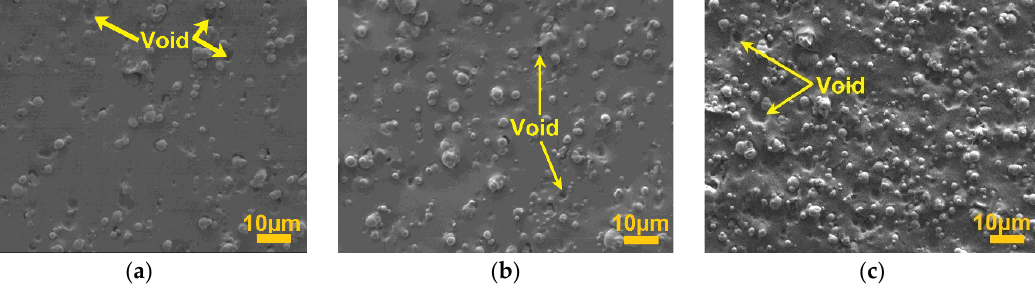
Figure 2. Microstructure of PDMS MREs under magnifications of 1200× with CIPs of ( a ) 60, ( b ) 70, and ( c ) 80 wt.%.